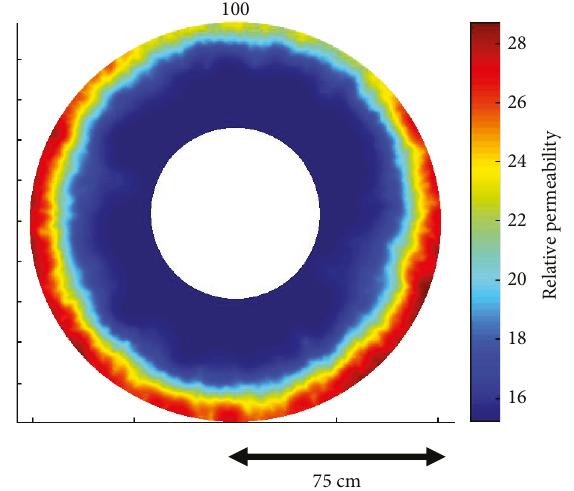
Figure 8: 2D Darcy fl ow simulation grid for computing wellbore- centric velocity variations due to spatially correlated porosity distributions documented in Figure 4 for Klaipeda geological sections. The above-illustrated fl ow simulation shows the case for low-poro-connectivity parameter α ~ 3 characteristic of the “ deep fi ltration ” assumption for particulate transport. In the present simulation particulates are transported arbitrarily distances into the surrounding rock. If the poro-connectivity parameter is given values in the range 15 < α < 30 widely observed in hydrocarbon reservoirs, then particulate transport is con fi ned to the vicinity of the wellbore because most active fl ow channels become clogged with particulates; this case is illustrated in Figure 7(a). Figure 6 indicates that observed exponential injector decline at Klaipeda is consistent with near-wellbore occlusion rather than deep fi ltration